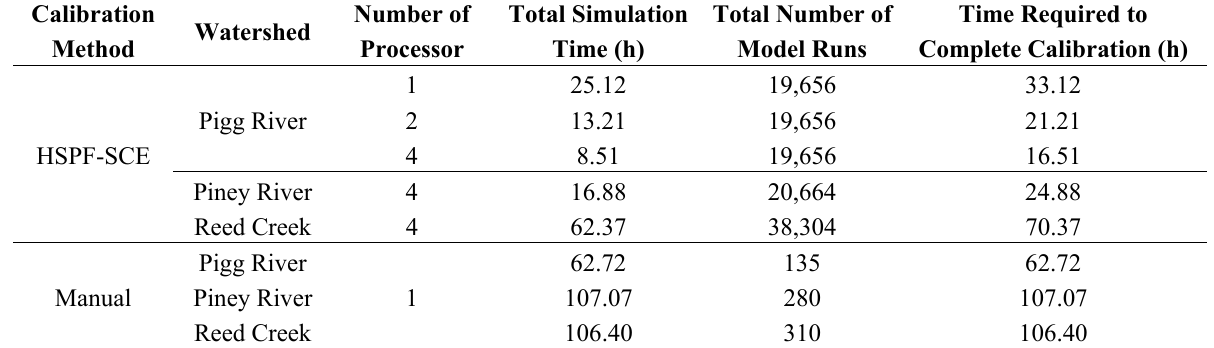
Table 10. Comparison of calibration time spent between automated and manual